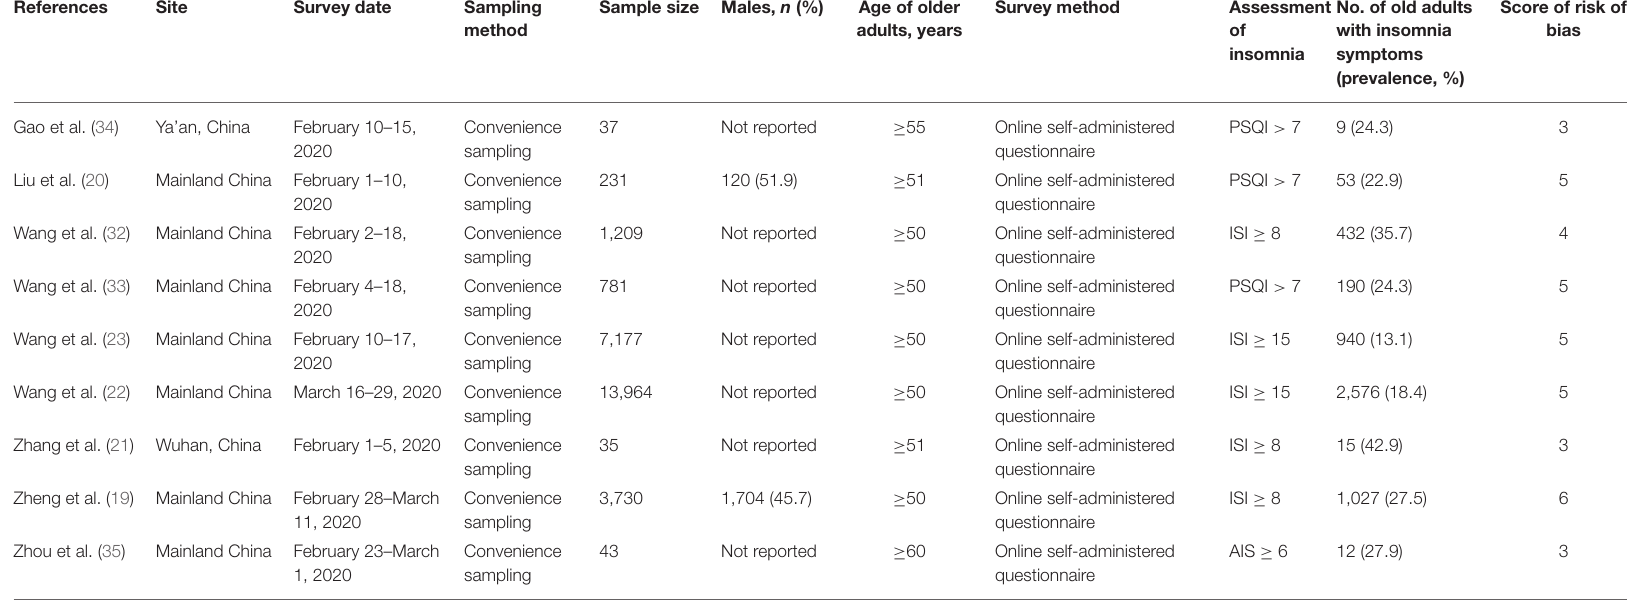
TABLE 1 | Characteristics of studies included in the